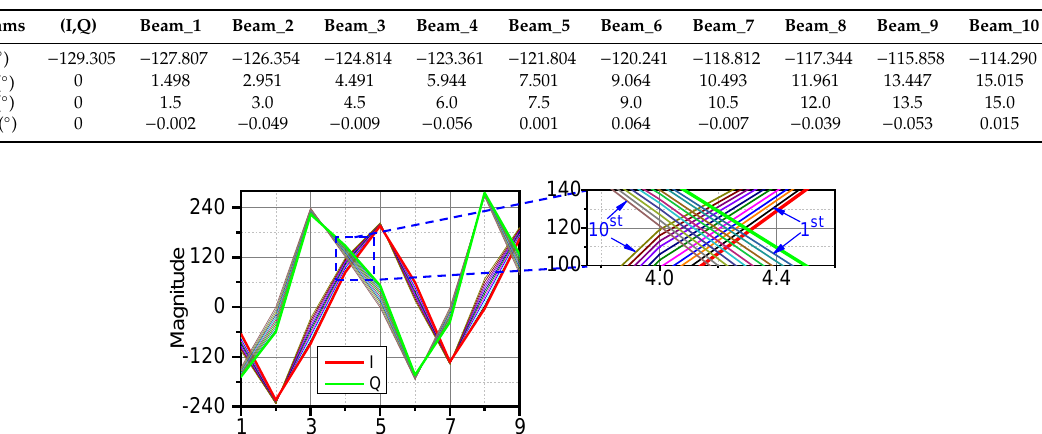
Table 4. Phase errors of FFT transform.